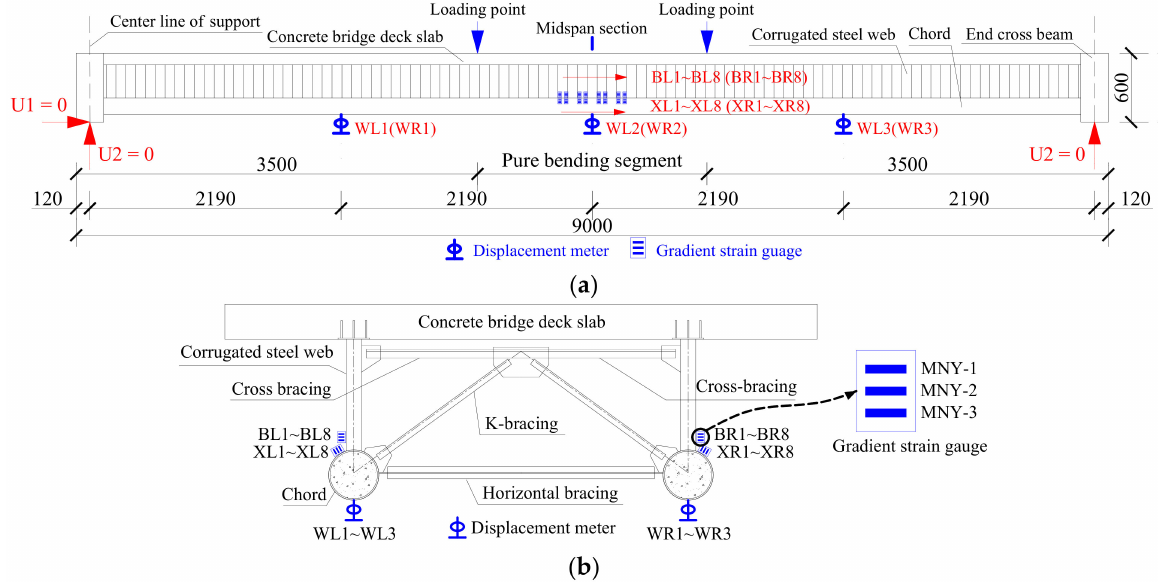
Figure 3. Scaled test model and layout of measurement points (unit: mm): ( a ) elevation; and ( b ) cross-section.